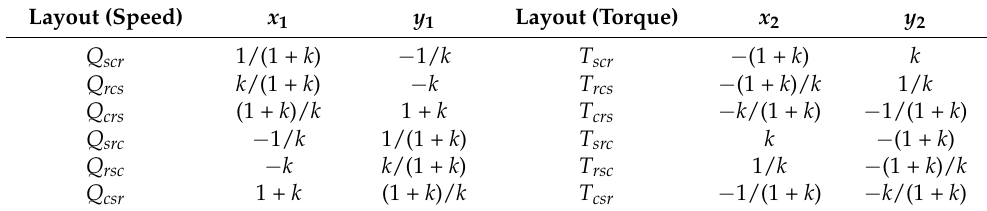
Table 2. Different layout of corresponding values of speed and torque when ( x ; y ) ∈ R 2